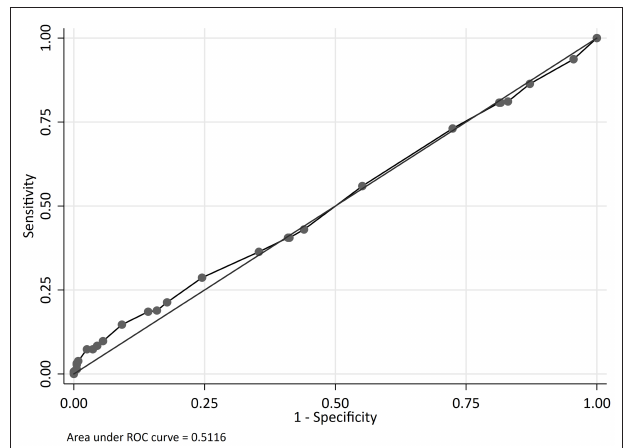
FIGURE 3 | Receiver operating characteristic (ROC) curve and Logistic regression for Pediatric Index of Mortality 2 (PIM2) predicting mortality.